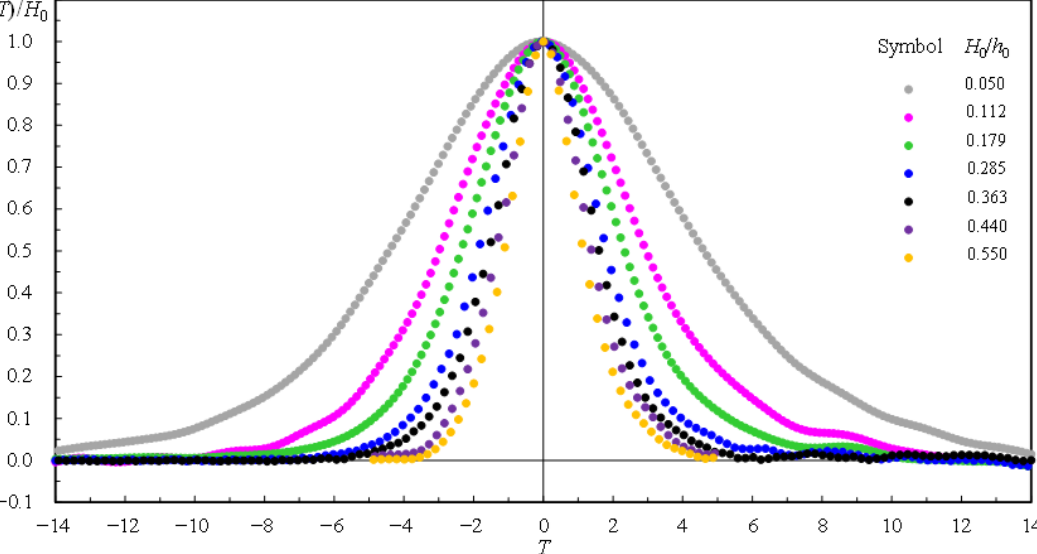
Figure 10. A comparison of temporal variations in the non-dimensional free surface elevation for H 0 / h 0 = 0.050–0.550.